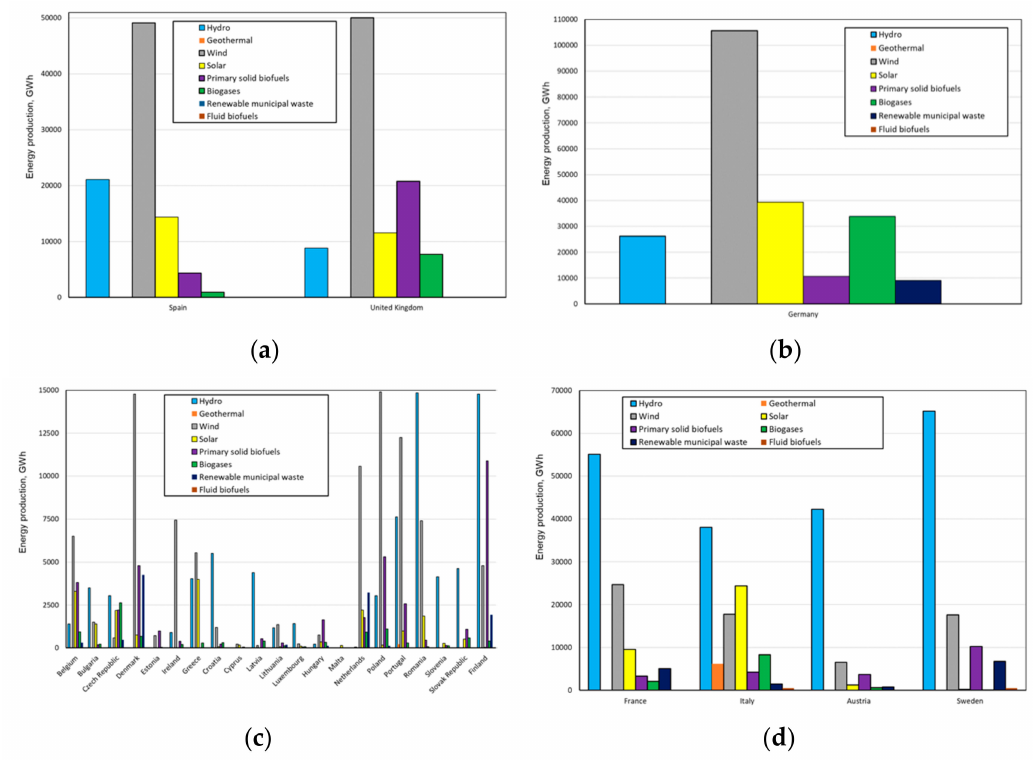
Figure 10. Structure and volume of energy production from renewable energy sources by countries in individual clusters; cluster 1 ( a ); cluster 2 ( b ); cluster 3 ( c ); cluster 4 ( d ) (own